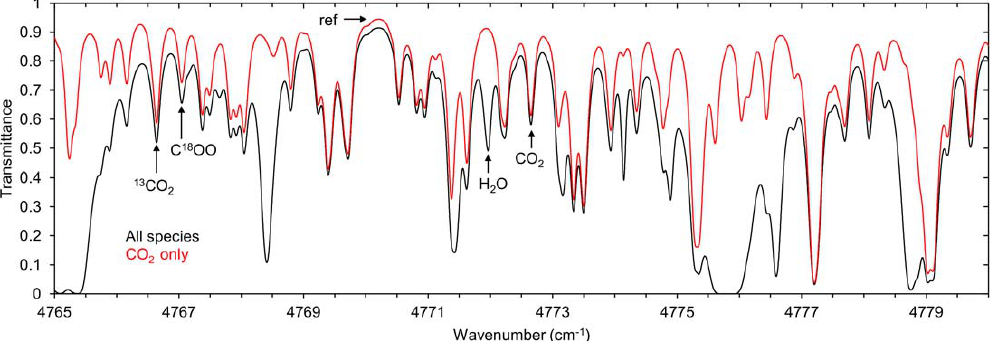
Fig. A1. Calculated spectrum of the CO 2 (2.1µm) region. This shows the region covered by the two IR lasers for CO 2 and H 2 O measurements (L1 and L2). CO 2 only – calculated for CO 2 only. All species – calculated including all relevant atmospheric species; almost all extra absorption is due to H 2 O. The labels indicate the originally targeted absorption line positions and reference (minimum absorption) position (cf. Table A1). Depending on actual frequency scan ranges (cf. Table A2), other spectral sections are used. For conditions see Appendix